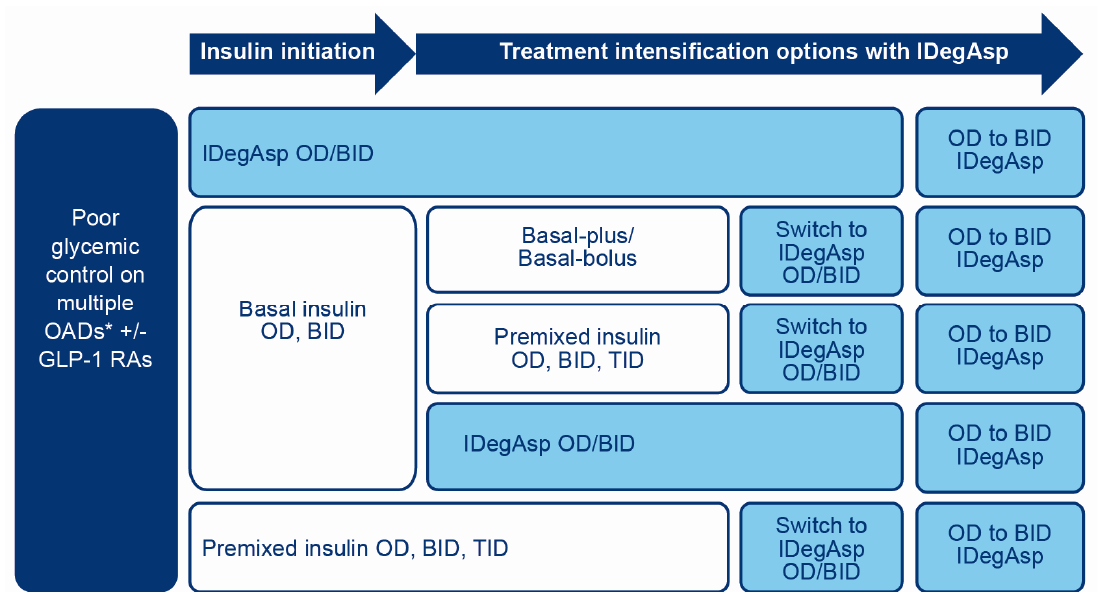
Figure 3. Situations where IDegAsp could be considered in T2D patients requiring insulin therapy. *Sulfonylurea, TZD, DPP-4i, SGLT2i. BID, twice daily; DPP-4i, dipeptidyl peptidase-4 inhibitor; GLP-1RA, glucagon-like peptide-1 receptor agonist; IDegAsp, insulin degludec / insulin aspart co-formulation; OAD, oral antidiabetic drug; OD, once daily; SGLT2i, sodium-glucose cotransporter-2 inhibitor; TID, three times daily; T2D, type 2 diabetes; TZD,